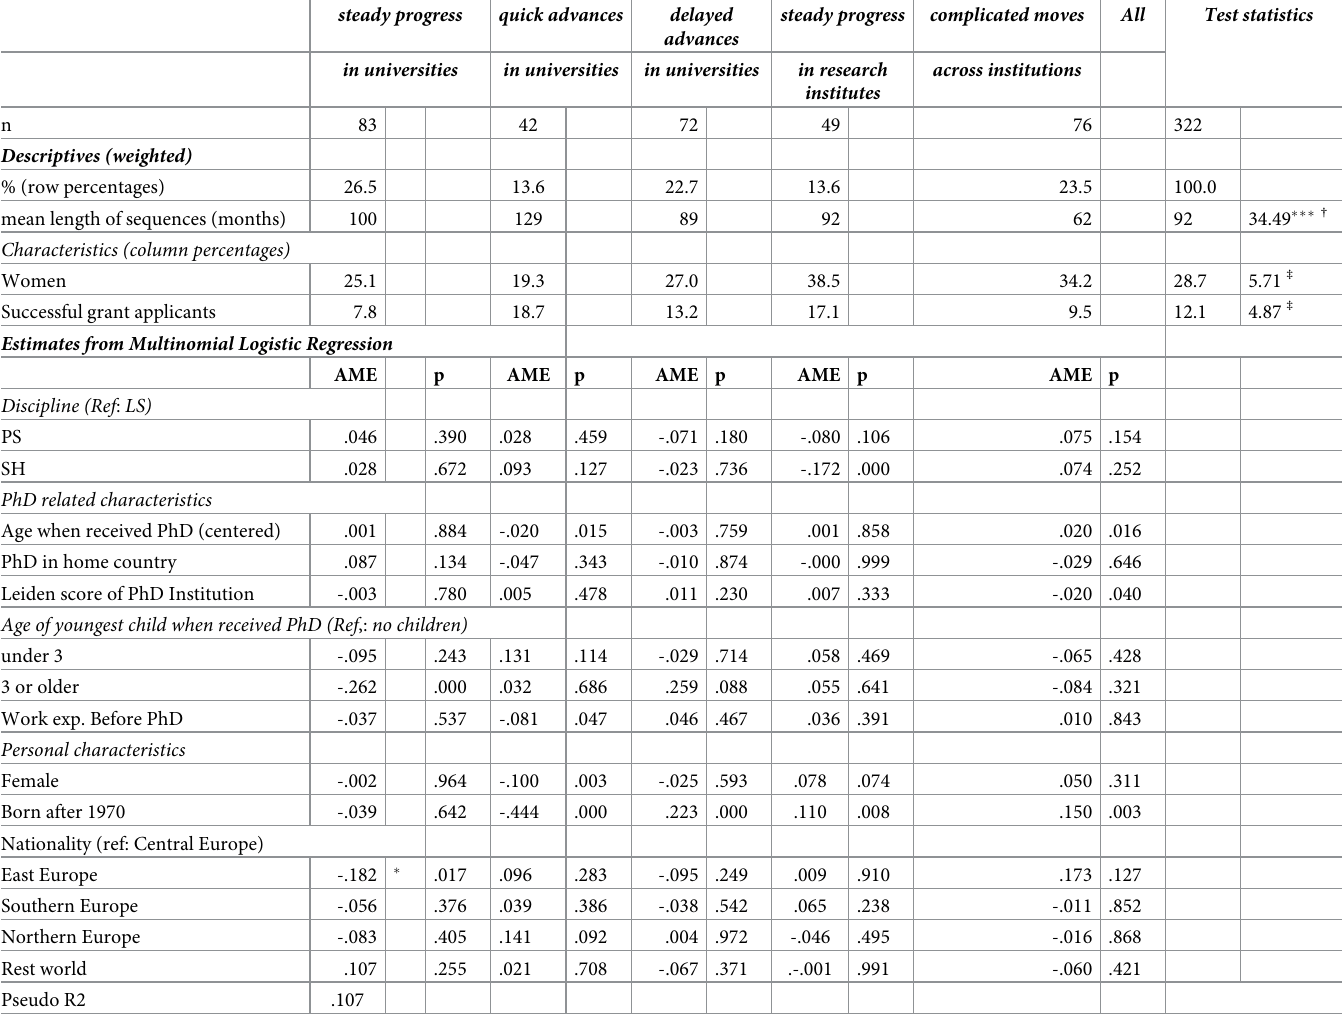
Table 2. Researchers in the Starting Grant (StG) patterns (descriptives, multinomial logistic regressions, average marginal